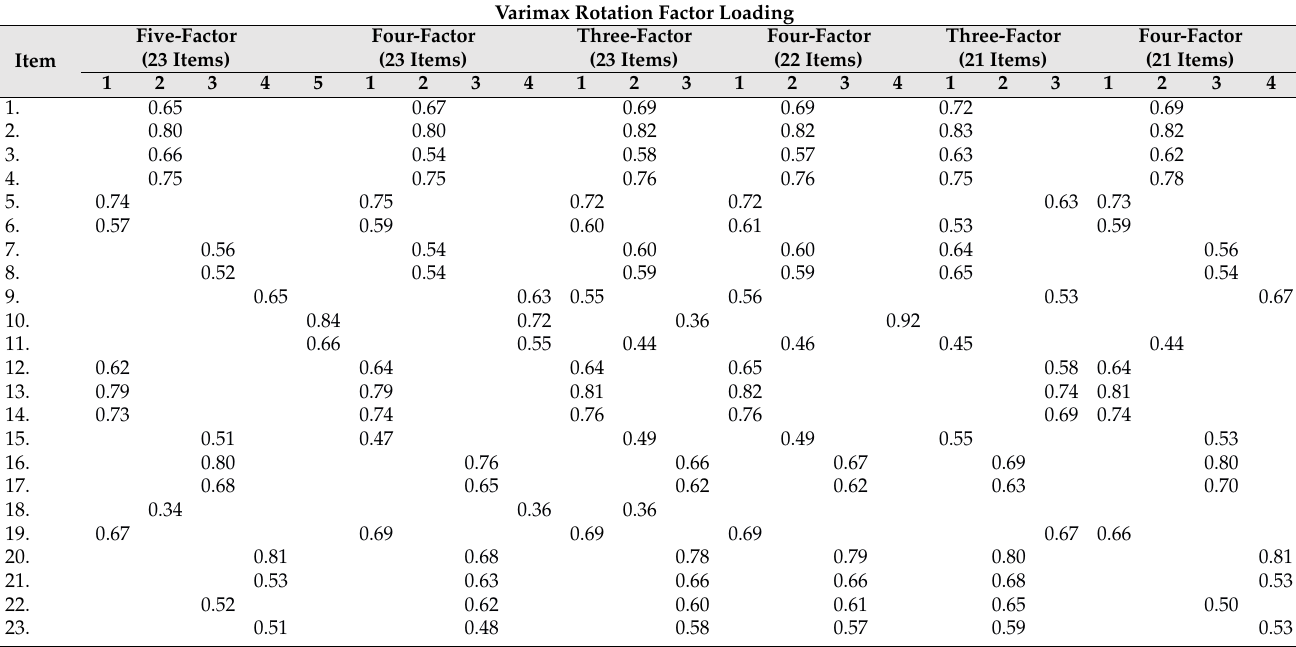
Table 4. Value of Varimax rotation factor loading a .